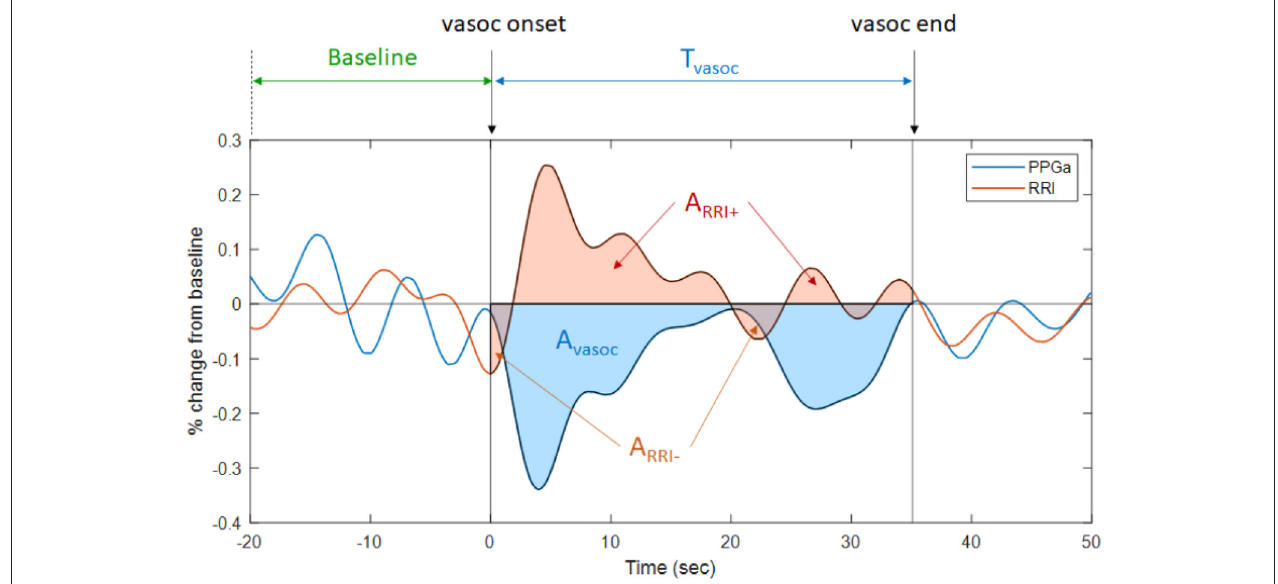
FIGURE 1 | Illustration of the changes in PPGa (blue tracing) and RRI (brown tracing) that occur during a vasoconstriction episode. T vasoc represents the duration between the onset and end of a vasoconstriction episode. A vasoc (blue-shaded area) represents the cumulative amount of vasoconstriction over T vasoc . The average magnitude of vasoconstriction for this episode, M vasoc , is calculated as the ratio between A vasoc and T vasoc . Thus, M vasoc is also the average percent change in PPGa from pre-vasoconstriction baseline. A RRI − is the RRI area below baseline during vasoconstriction (i.e., cumulative amount of heart rate increase during this vasoconstriction episode). A RRI + is the RRI area above baseline (i.e., cumulative amount of heart rate decrease during vasoconstriction episode). M vasoc , A RRI − , A RRI + , and total number of vasoconstriction episodes (N vasoc , not shown in figure) were selected as features representing vasoconstriction